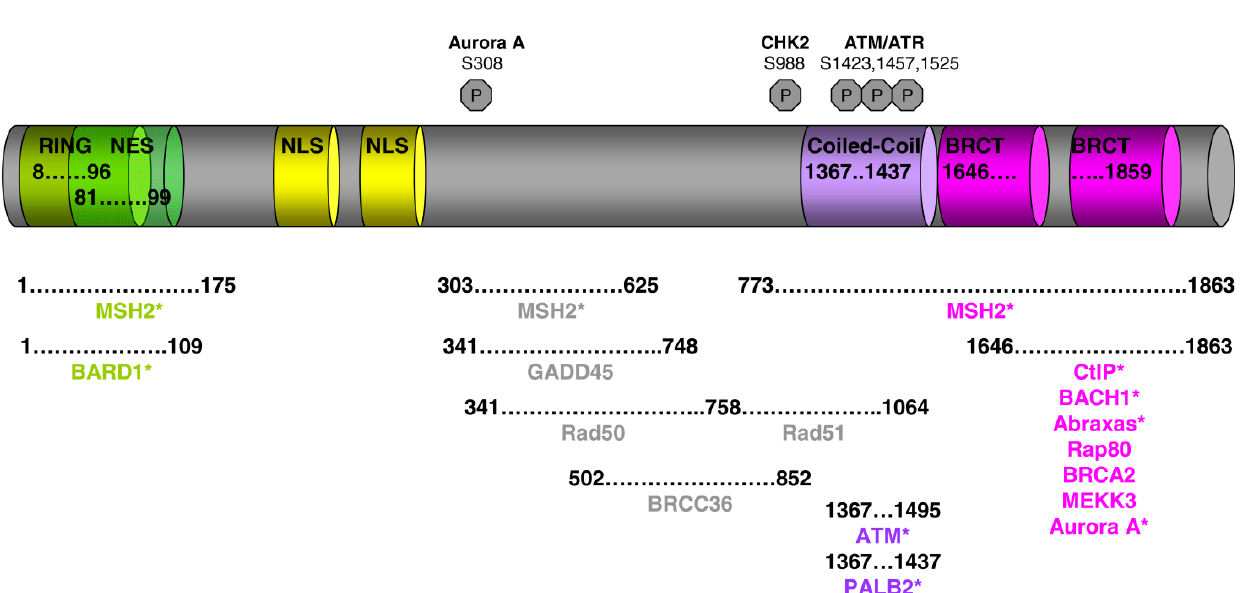
Figure 1. BRCA1 functional domains and its partners. Asterisks denote direct interaction with